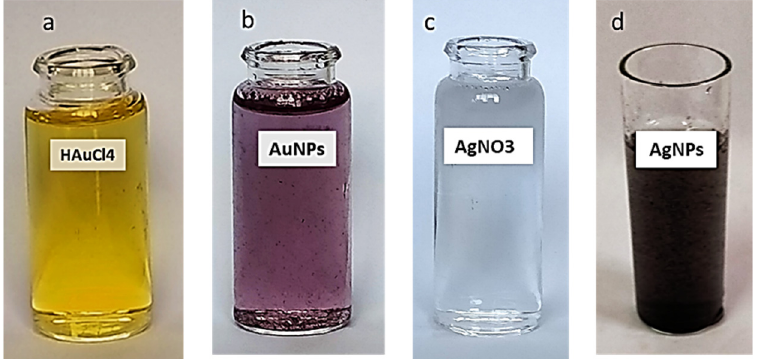
Figure 2. Change in color due to the formation of nanoparticles. ( a ) HAuCL4, ( b ) AuNPs, ( c ) AgNO3,